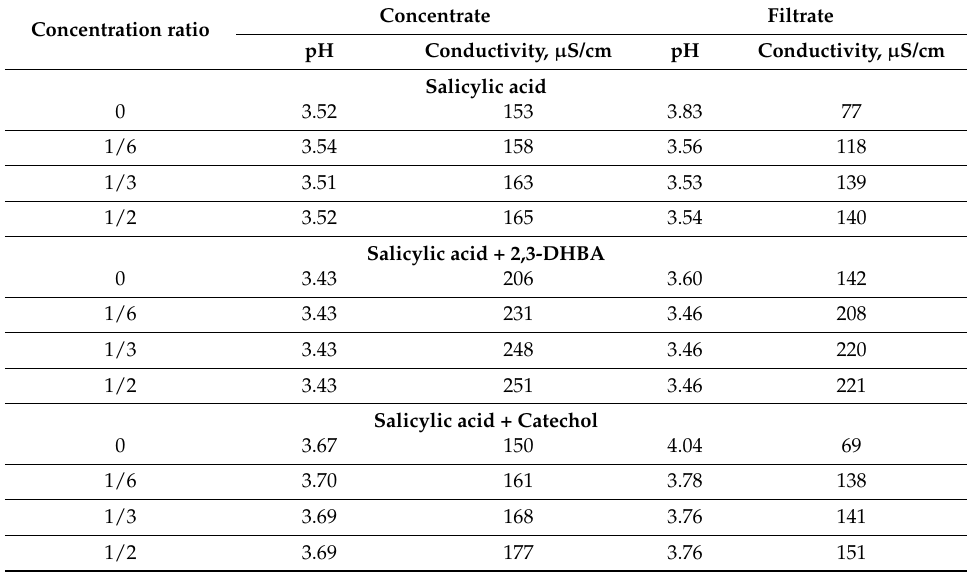
Table 4. The pH and conductivity of concentrates and filtrates obtained during filtration on the HL